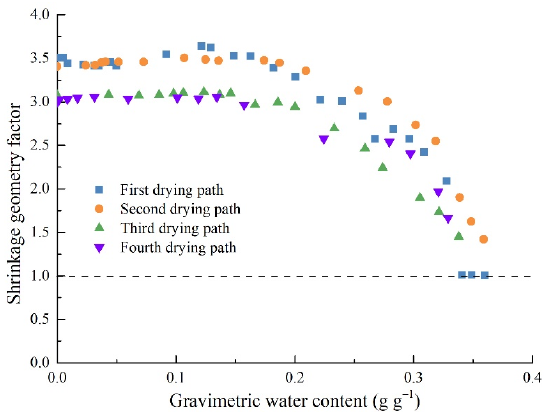
Figure 6. Variation of shrinkage geometry factor with decreasing soil water content during four drying paths. For brevity, only the data of replicate 1 are presented. drying paths. For brevity, only the data of replicate 1 are